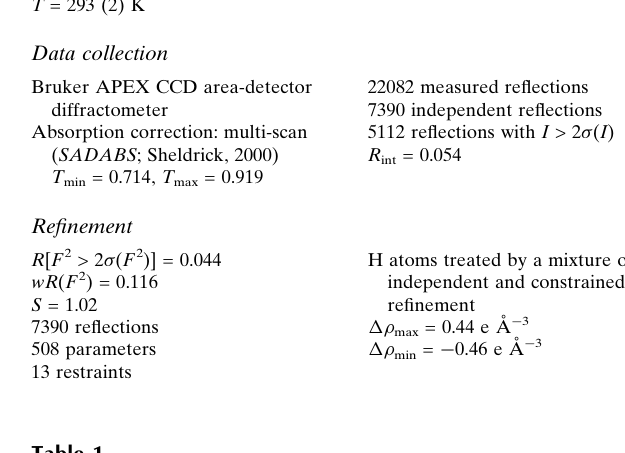
Hydrogen-bond geometry (A˚ , (cid:2)